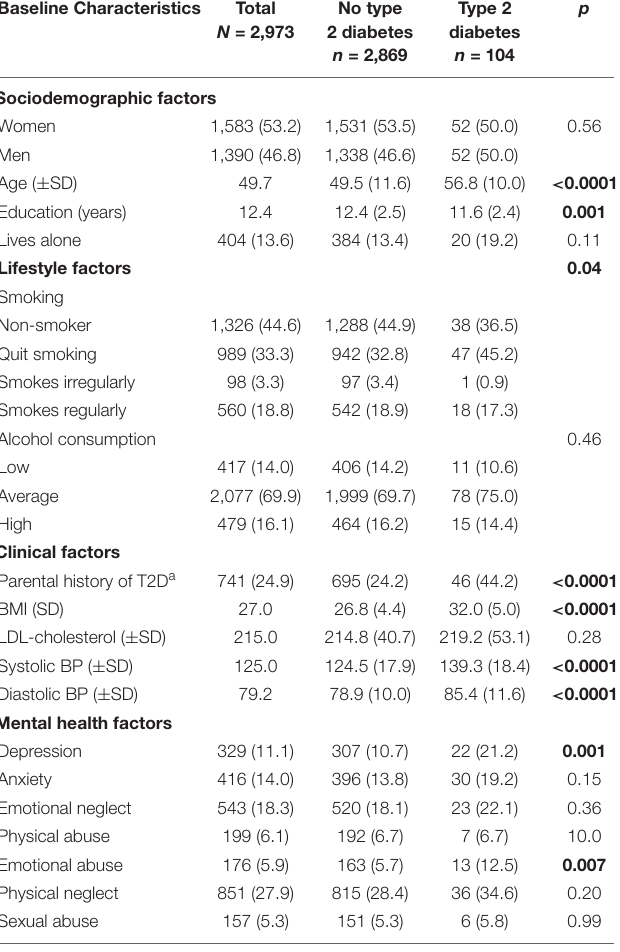
TABLE 2 | Characteristics of the pooled study population according to type 2 diabetes outcome ( N , % or mean ± SD) in 2,973 participants (1,583 women and 1,390